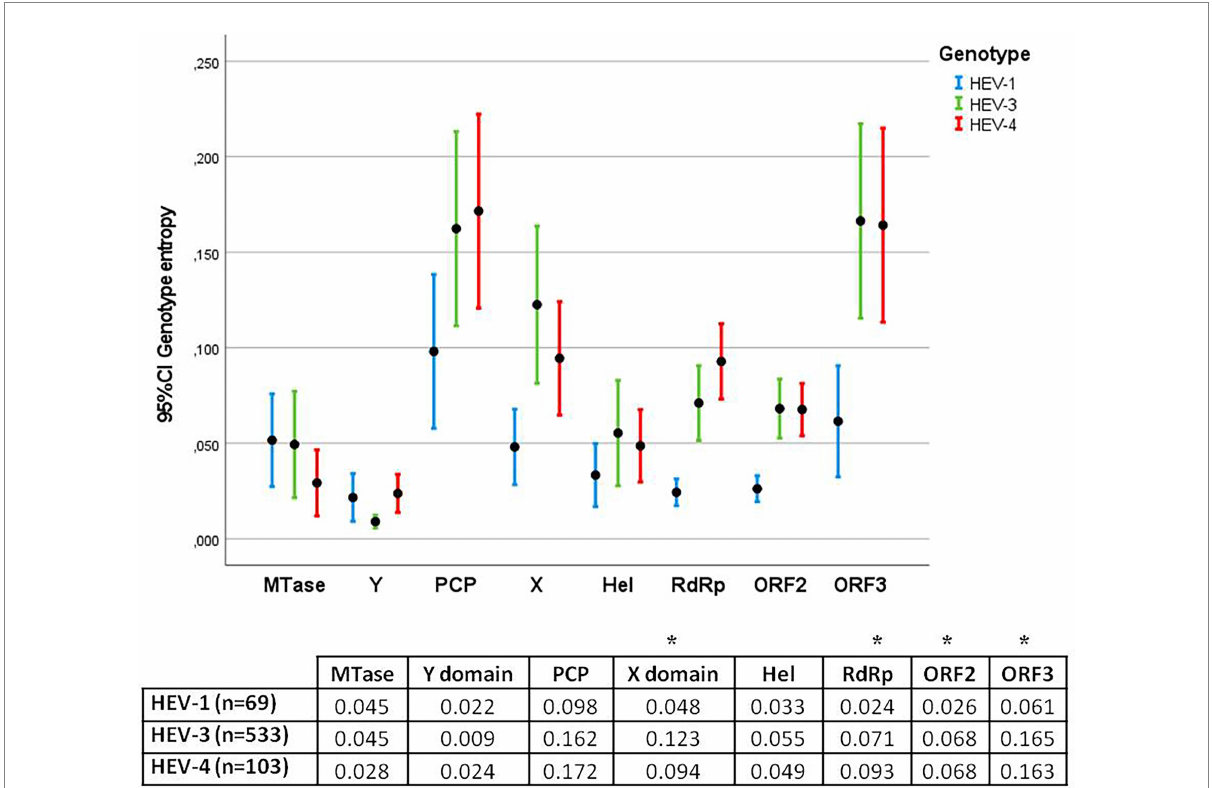
FIGURE 3 Error bar graph showing the mean entropy and 95% confidence interval (CI) for each protein in HEV-1, HEV-3, and HEV-4. The table below shows the average entropies of each protein. Statistically significant differences between genotypes were observed in the X domain, RdRp, ORF2 and ORF3